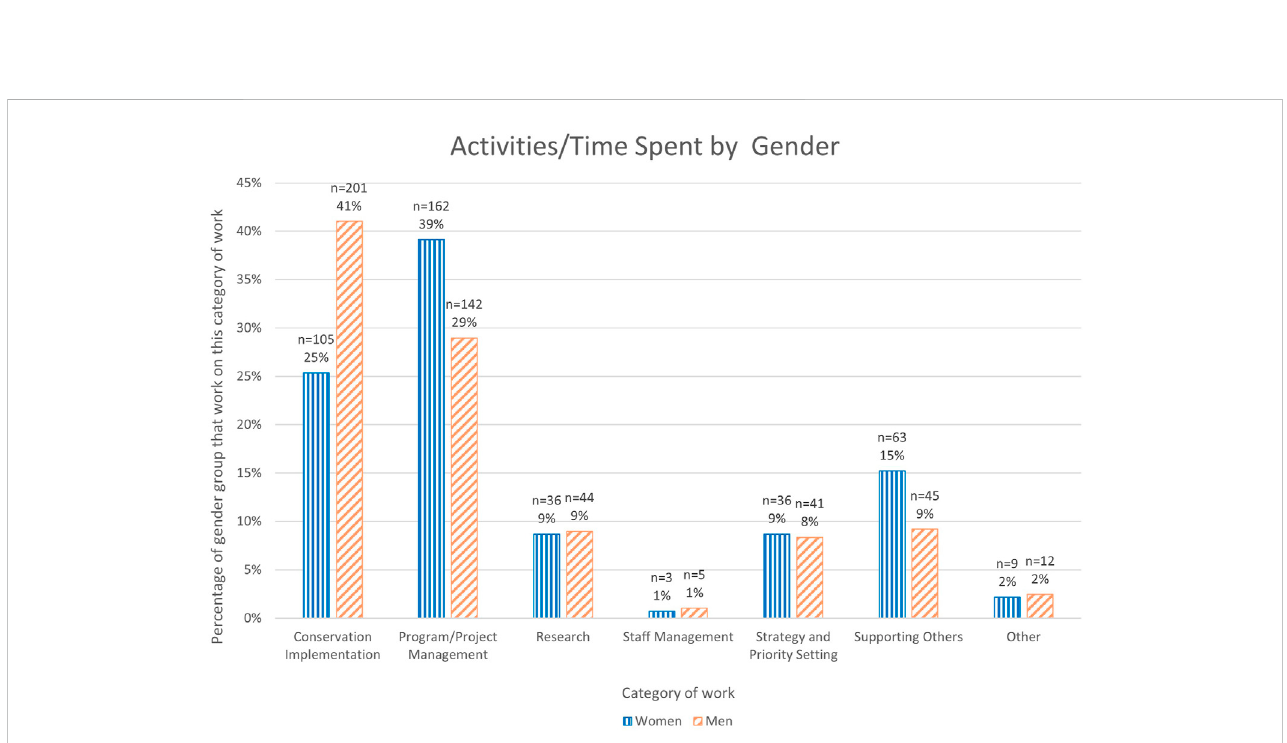
FIGURE 2 Graph of responses to Q1. Is your role predominantly? (Chosen from a drop down list). As a percentage of the total number of respondents for each